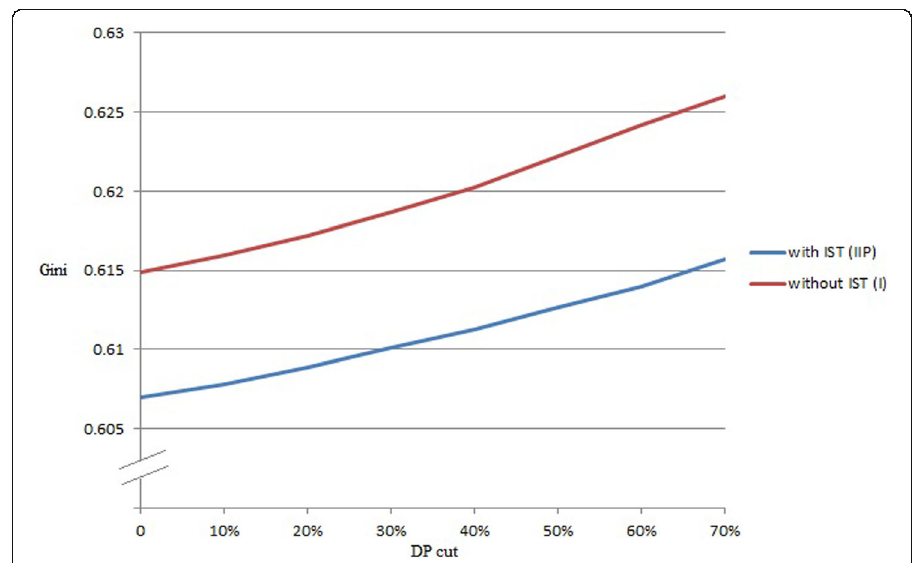
Fig. 4 Normalized Gini coefficient of farm income with (IIP) and without the IST (I) for different reductions of direct payments level. Calculated on all farms of the sample, whole 2012 – 2015 period. Source: Own elaborations on Italian FADN